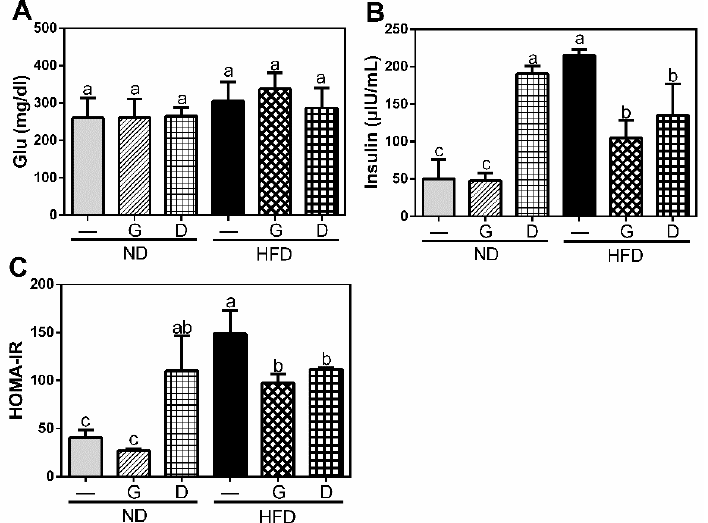
Figure 4. Effects of garlic supplementation on serum level of glucose ( A ) and insulin ( B ) and homeostatic model assessment for insulin resistance (HOMA-IR) ( C ). The data represent the mean ± SD of five mice. Columns with different letters significantly differ ( p < 0.05).